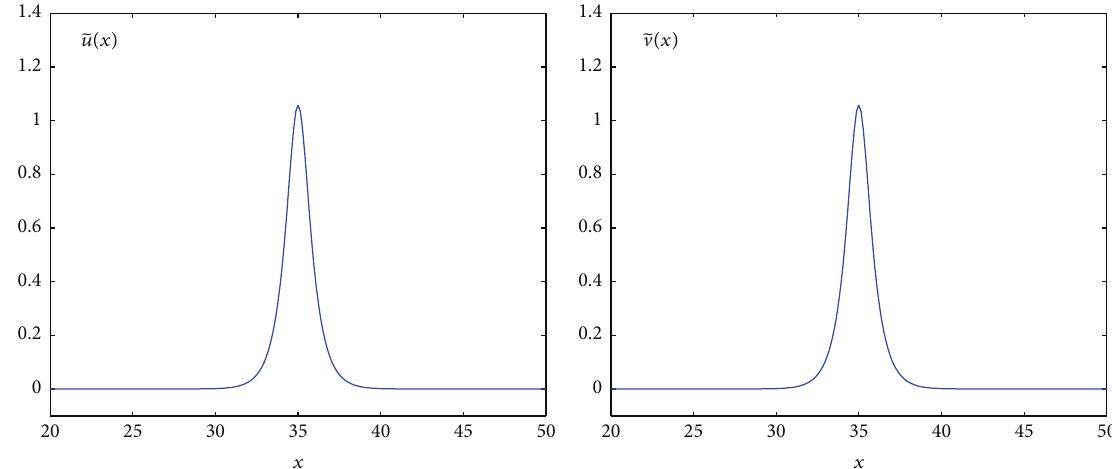
Figure 6: Vector soliton of system (1) obtained after 10 Newton’s iterations and 𝛿 = 1 , 𝜎 1 = 𝜎 2 = 0 , and 𝛼 1 = 𝛼 2 = 1.5 .